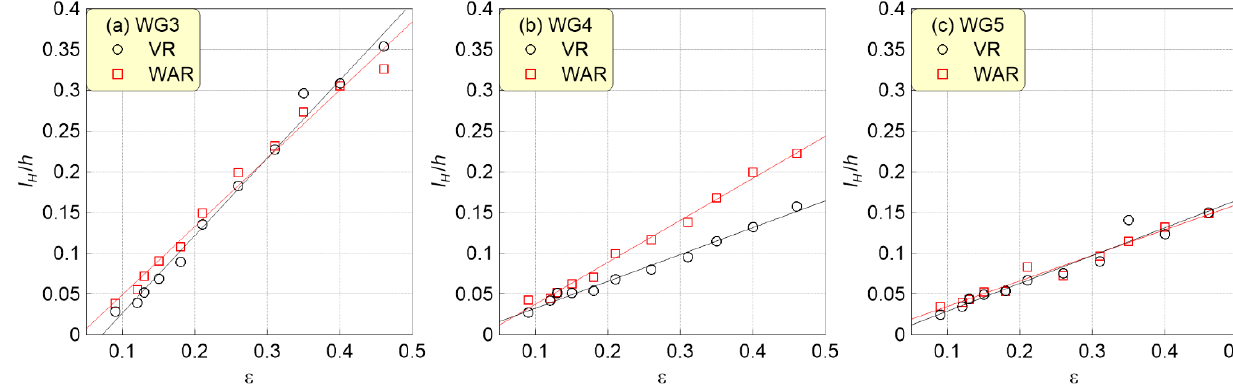
Figure 7. Distributions of maximum inundation heights according to 𝜀 at the VR and WAR.